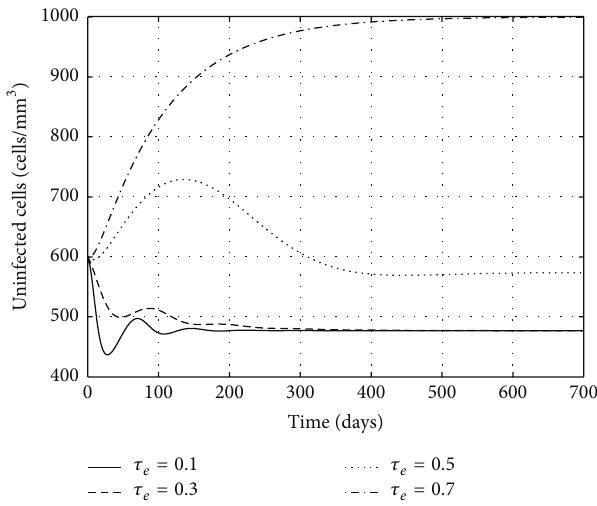
Figure 9: The concentration of free virus particles for model (104).